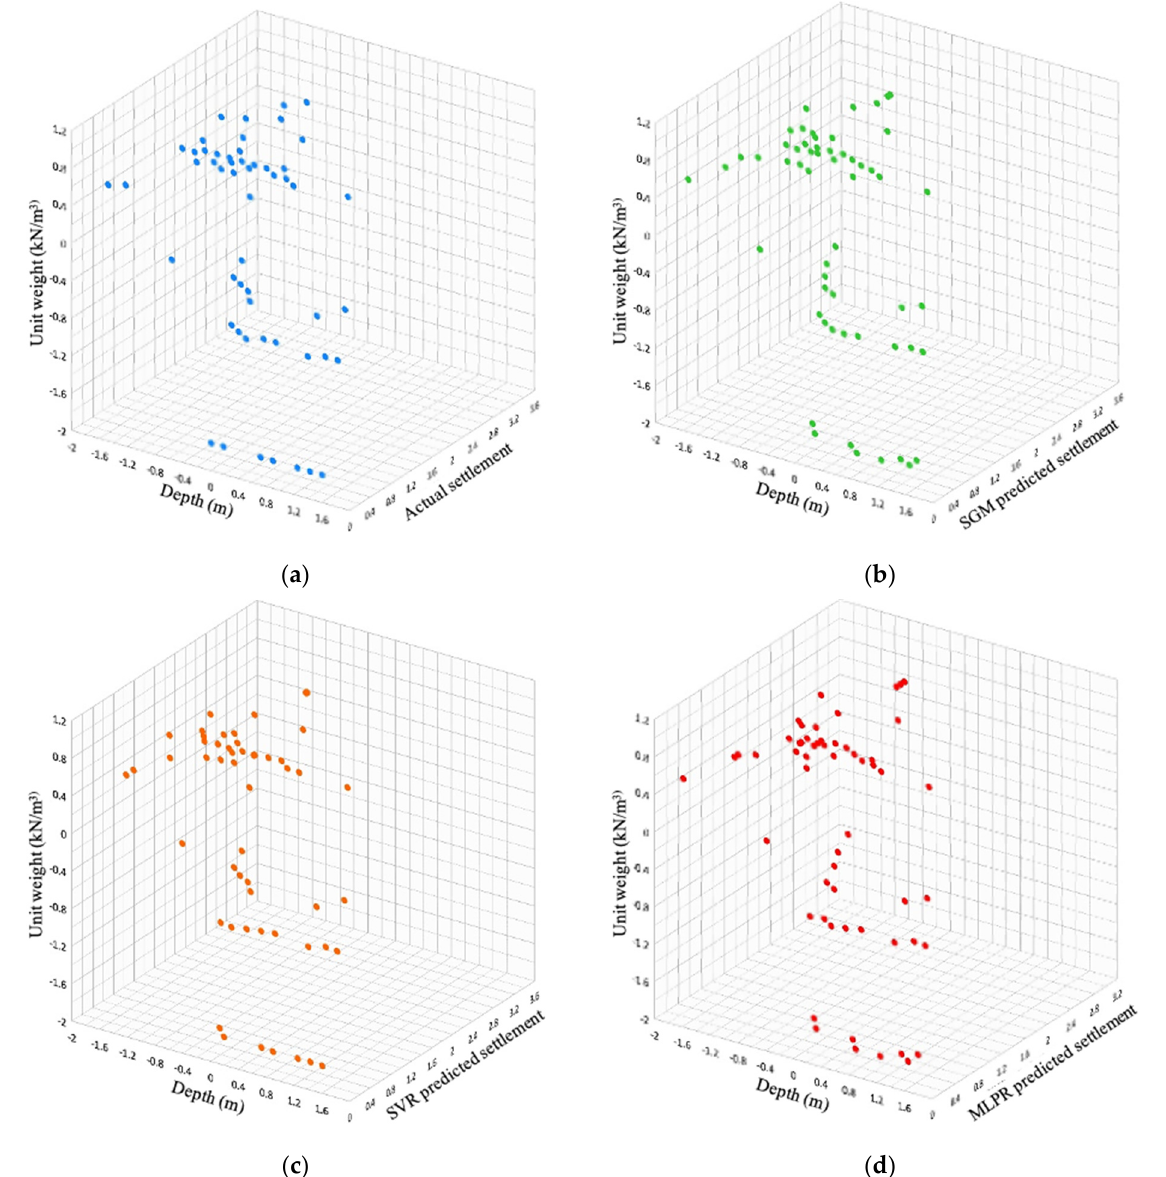
Figure 12. Settlement comparison with unit weight and depth features of SPT. ( a ) Actual settlement; ( b ) SGM-predicted settlement; ( c ) SVR-predicted settlement; ( d ) MLPR-predicted settlement.